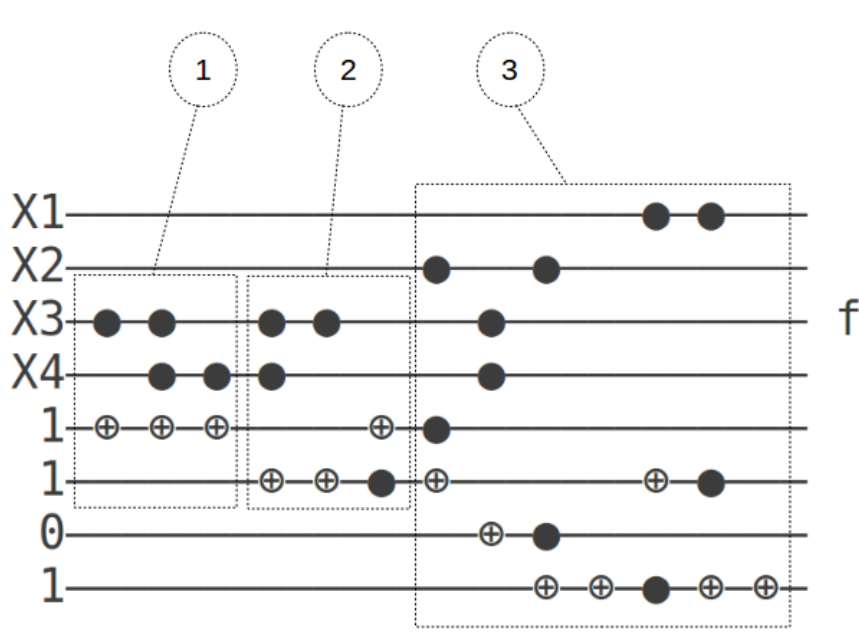
Figure 8. Generated reversible circuit constructed for the BDD in Figure 6 where 1, 1, 0 and 1 are control lines and f represents the output of the circuit. The three labels 1, 2, and 3 are related to the investigated subtrees in Figure 6.